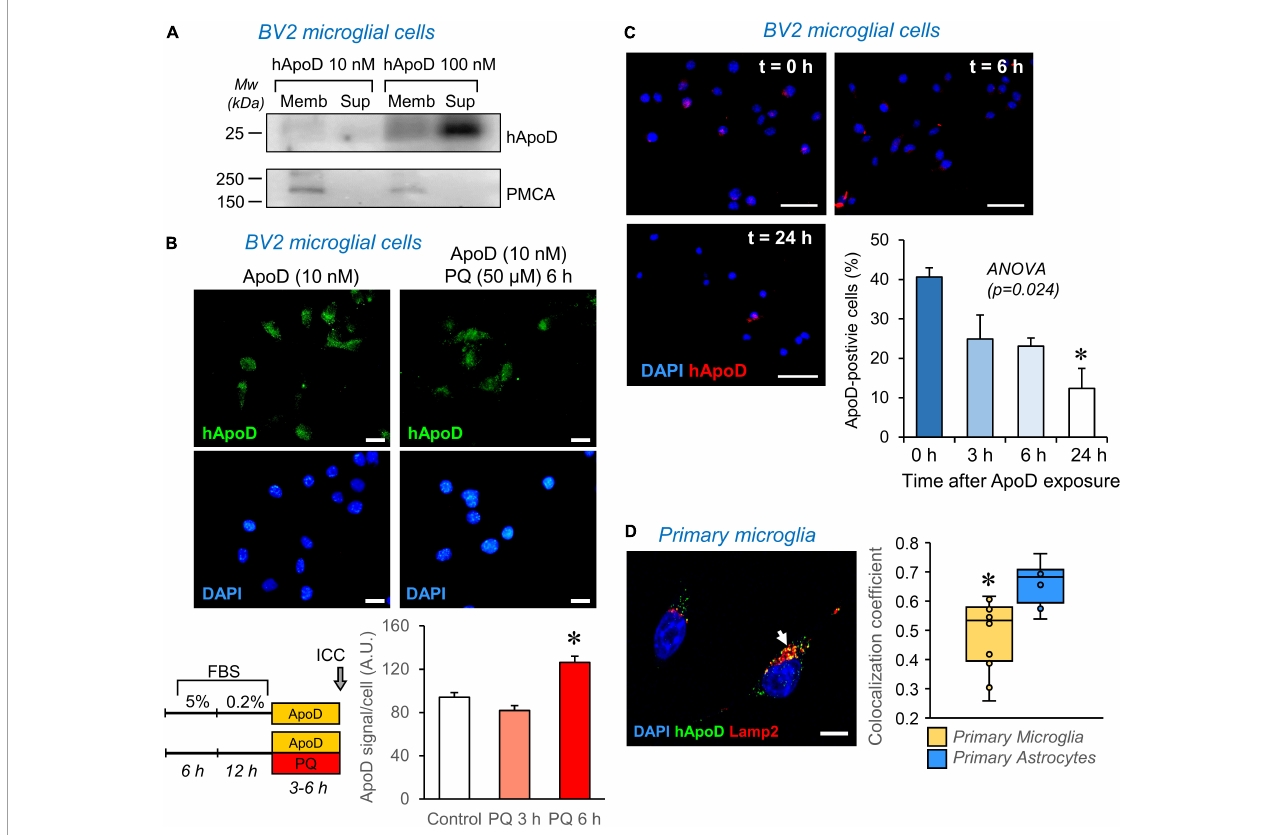
FIGURE6 ApoD interacts with microglial cell membranes and is internalized to the late-endosome-lysosomal compartment. (A) Human ApoD interacts with BV2 cell membranes in a dose dependent manner. Equivalent volumes of membrane-bound and unbound (supernatant; Sup) protein extracts were analyzed by immunoblot. The integral plasma membrane protein PMCA is used as positive control. (B) Internalization of exogenous ApoD in BV2 is time and PQ-dependent. (C) After 3 h exposure to 50 nM ApoD, the internalized ApoD steadily decreases with time in BV2 cells. (D) Exogenously added ApoD traffics to the late-endosome-lysosomal compartment of primary mouse microglia in control conditions, but with a lower co-localization index than that of primary astrocytes. N = 2 independent experiments (A) or three independent experiments (B—D) . Co-localization index in (D) measured in z -stacks from 12 microglial cells and 8 astrocytes. Asterisks point to significant differences. Calibration bars (B) : 20 µ m; (C) : 50 µ m; (D) : 10 µ